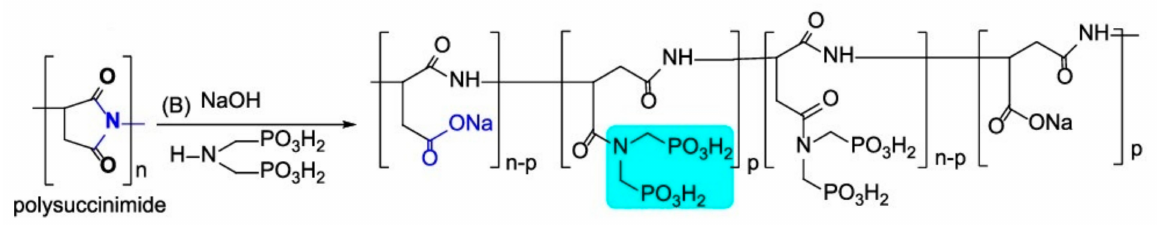
Figure 7. Synthesis of modified polyaspartic acid with aminomethylene phosphonic acid